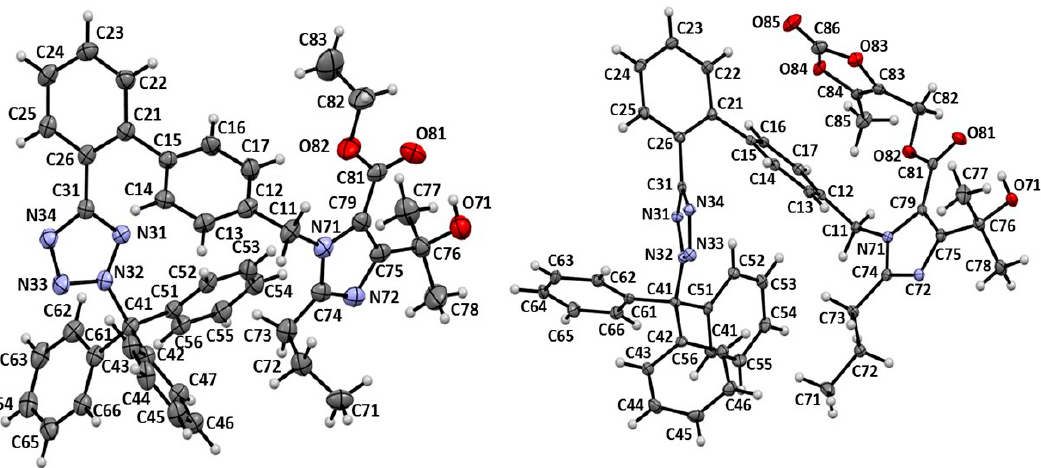
Figure 2. Molecular structure of N -tritylolmesartan ethyl ( 3 , left ) and N -tritylolmesartan medoxomil ( 6 , right ).